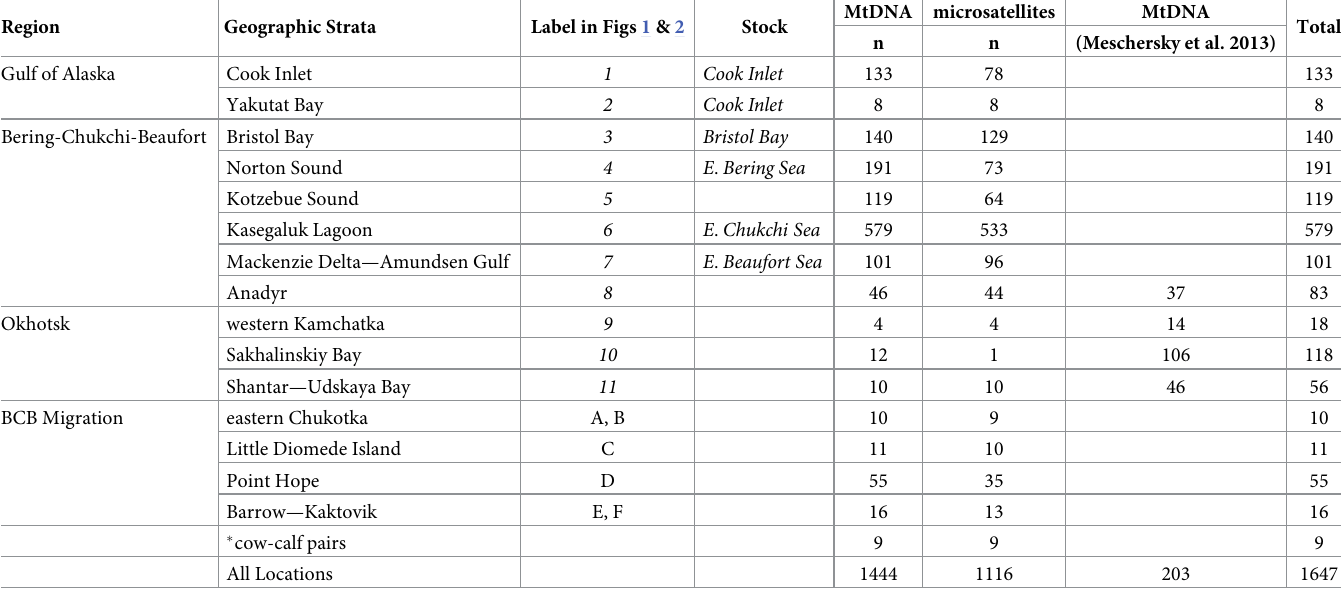
Table 1. Sample sizes of beluga whales from fifteen geographic strata in the north Pacific: A resident population (Cook Inlet) and a separate small resident group (Yakutat Bay) in the Gulf of Alaska, six summering areas in the Bering, Chukchi, and Beaufort Seas, three summering areas in the Okhotsk Sea, and four locations along the northbound spring migration routes. Some of these strata have previously been identified as demographically separate management stocks based on mtDNA. While almost all samples were screened for microsatellites sample numbers for these nuclear markers indicate only those samples that yielded genotypes at six or more